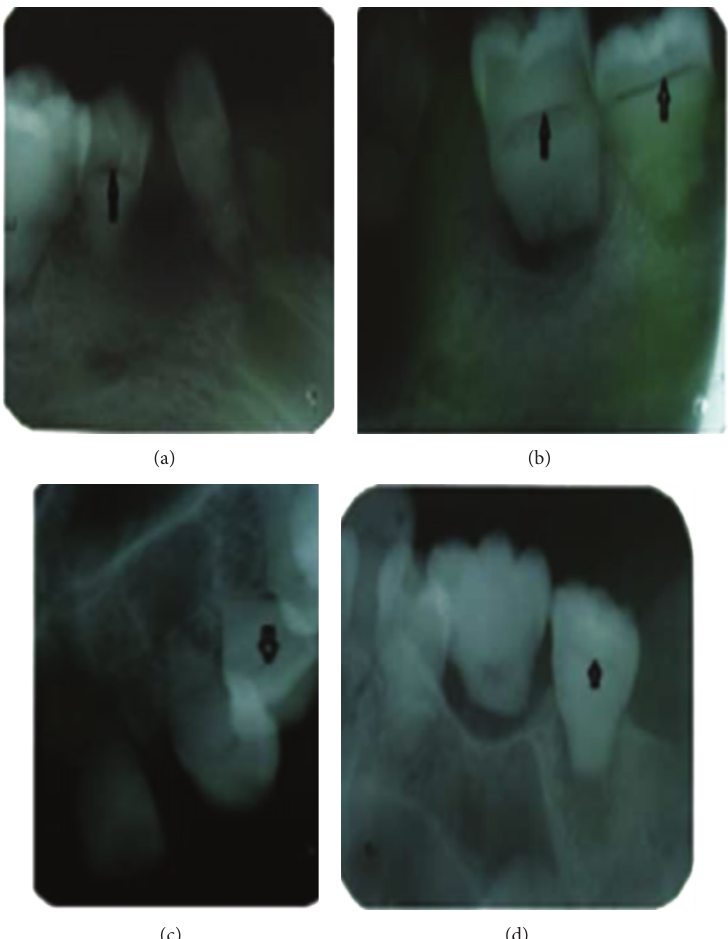
Figure 3: Intraoral periapical radiographs showing horizontal/crescent shaped pulpal remnants in pulp chambers (black